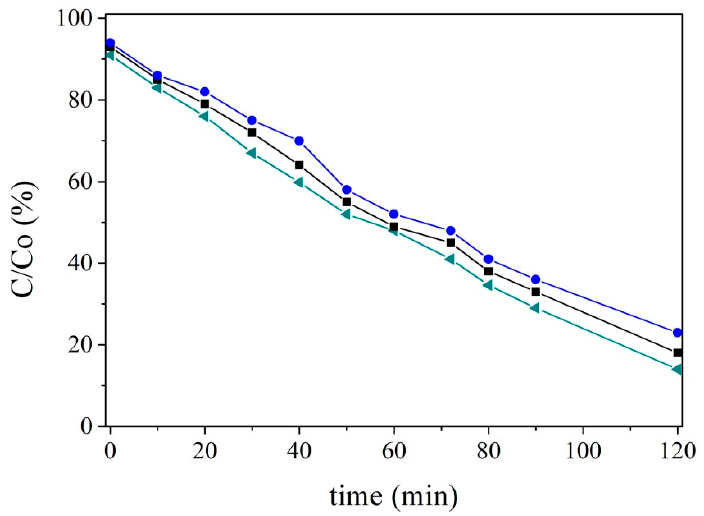
Figure 8. Decoloration of MB in the presence of the ZT-rGO catalyst with 2 wt % rGO for three photocatalytic cycles (cycle 1 ◀ , cycle 2 ◼ and cycle 3 ● ).